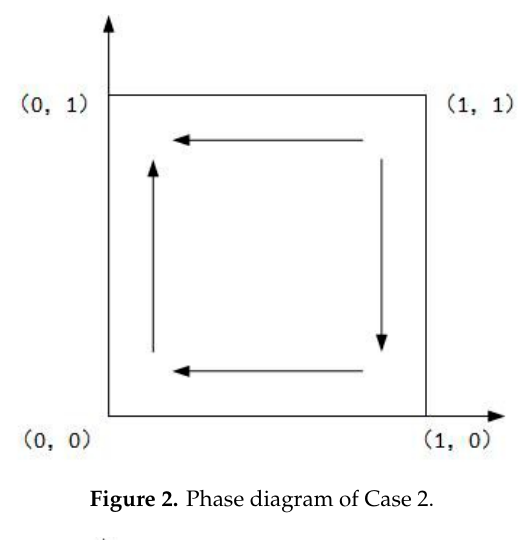
Figure 1. Phase diagram of Case 1.